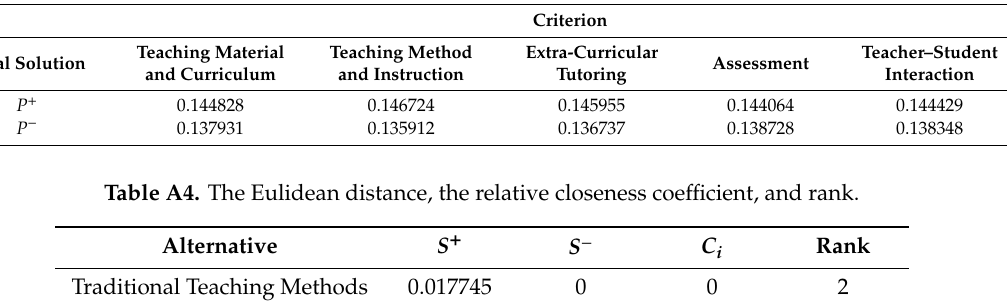
Table A3. The positive ideal solutions ( P + ) and negative ideal solutions ( P − ).